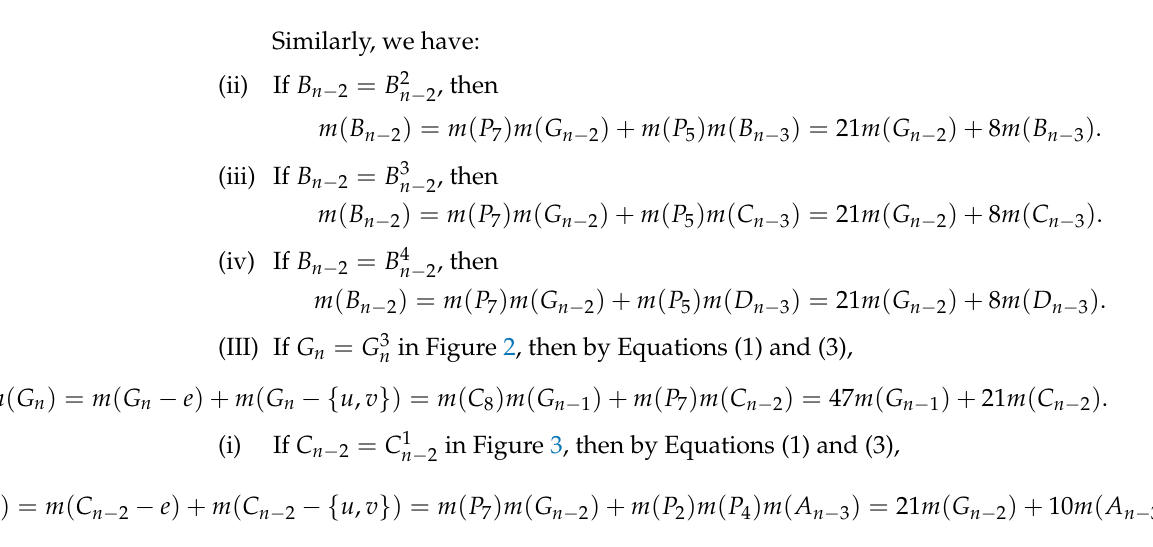
Figure 3. The four types of auxiliary